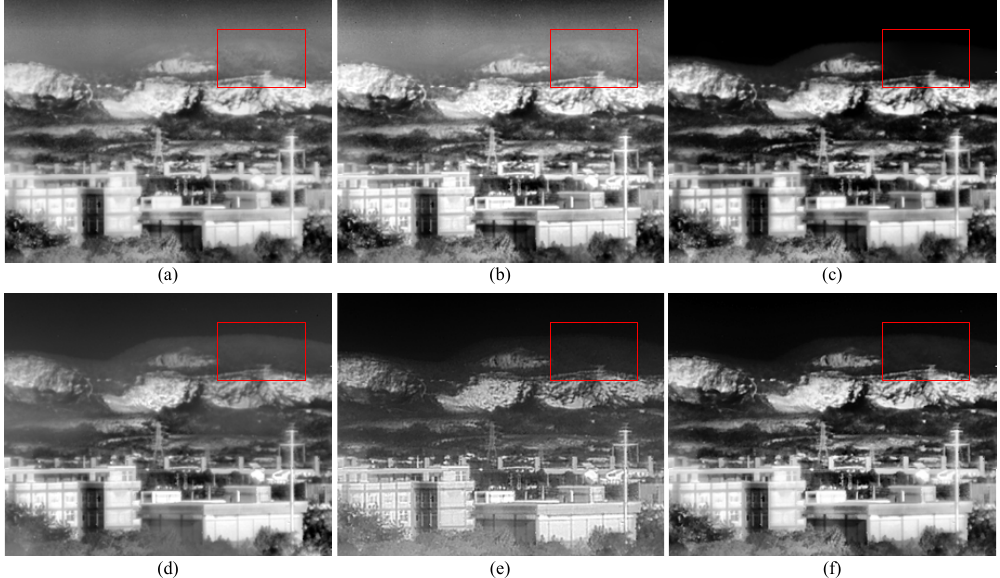
Figure 9. Enhancement results for Hills. ( a ) CLAHE, ( b ) BCCE, ( c ) ABMHE, ( d ) LGGSF, ( e ) GLHS, ( f ) Proposed.